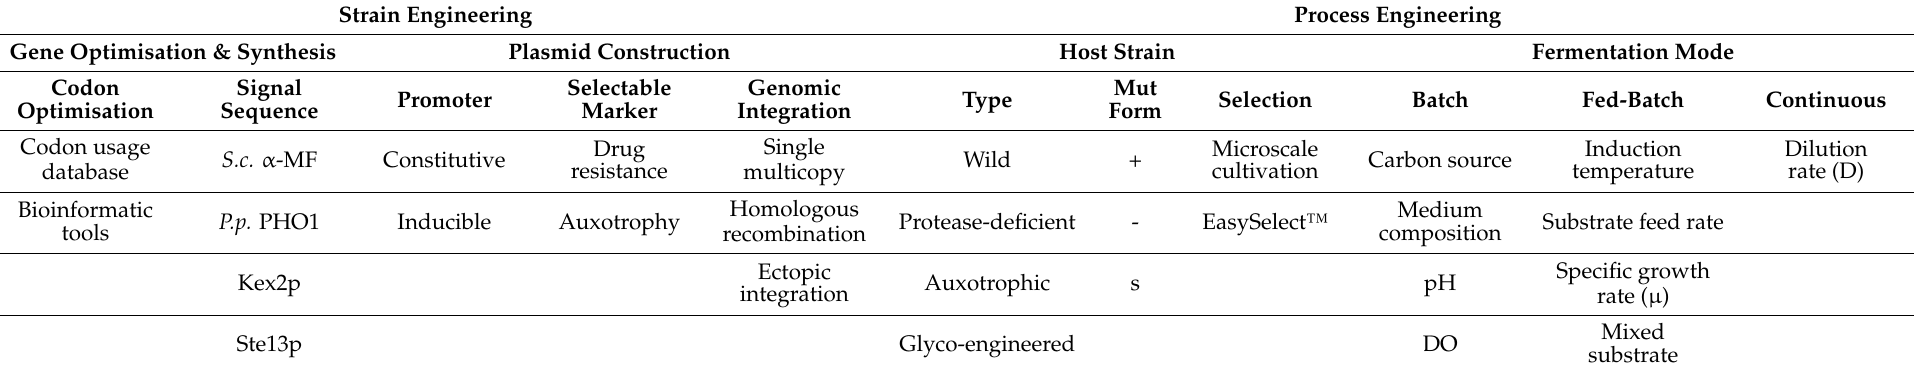
Table 5. Overall considerations for heterologous protein expression in P. pastoris manufacturing optimization